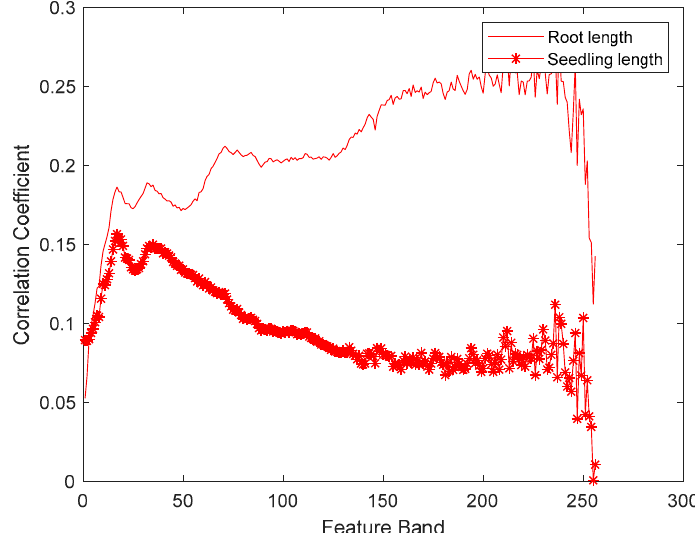
Figure 3. The correlation coe ffi cient between the hyperspectral data with the seedling length and root length.